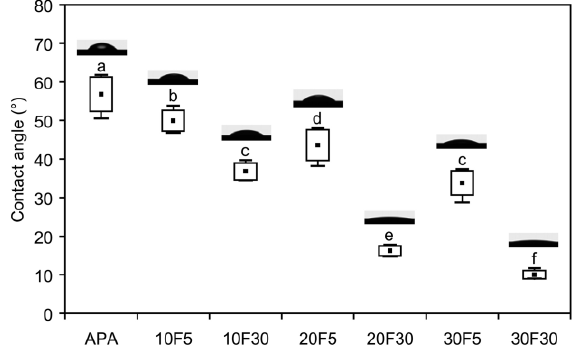
Figure 4. Contact angles of water droplets on the specimen surfaces. Black squares denote mean values, boxes represent standard deviations, and whiskers define the minimum and maximum values. Identical lower-case letters indicate statistically equivalent values ( p >